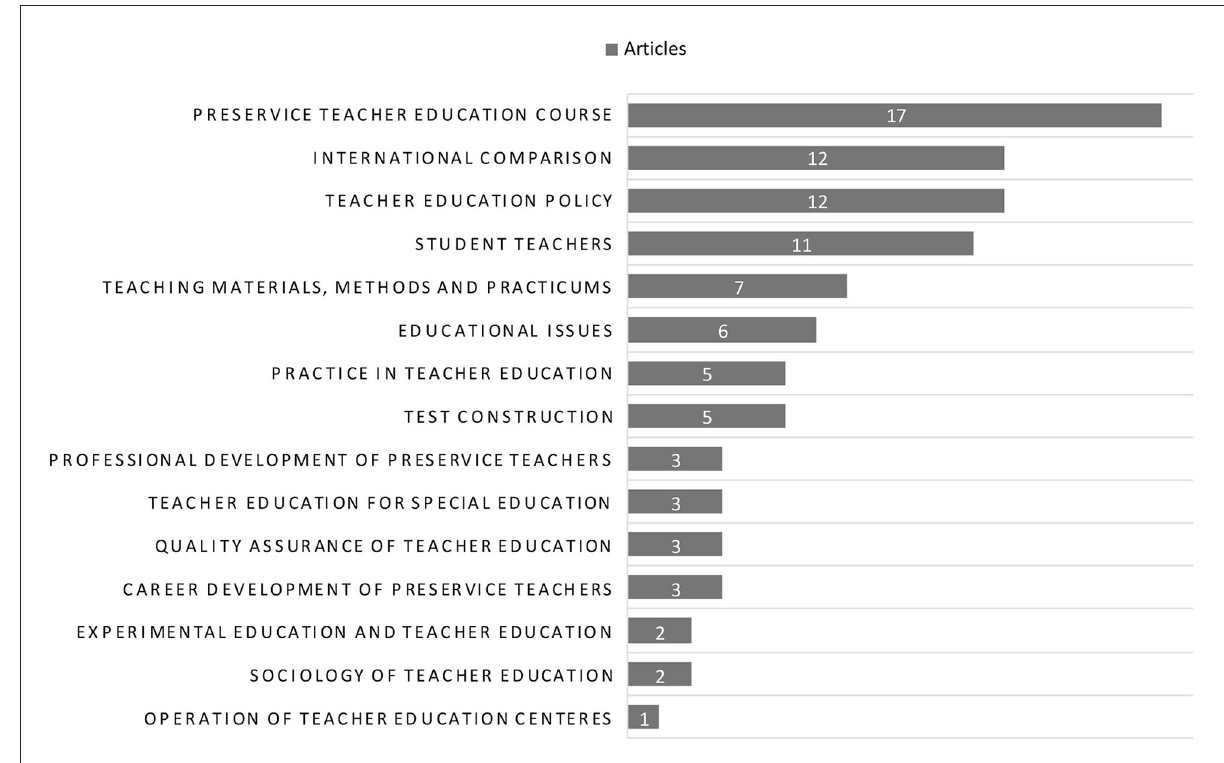
FIGURE1 Research issues and numbers of articles related to teacher education in Taiwan from 2015 to 2019. The